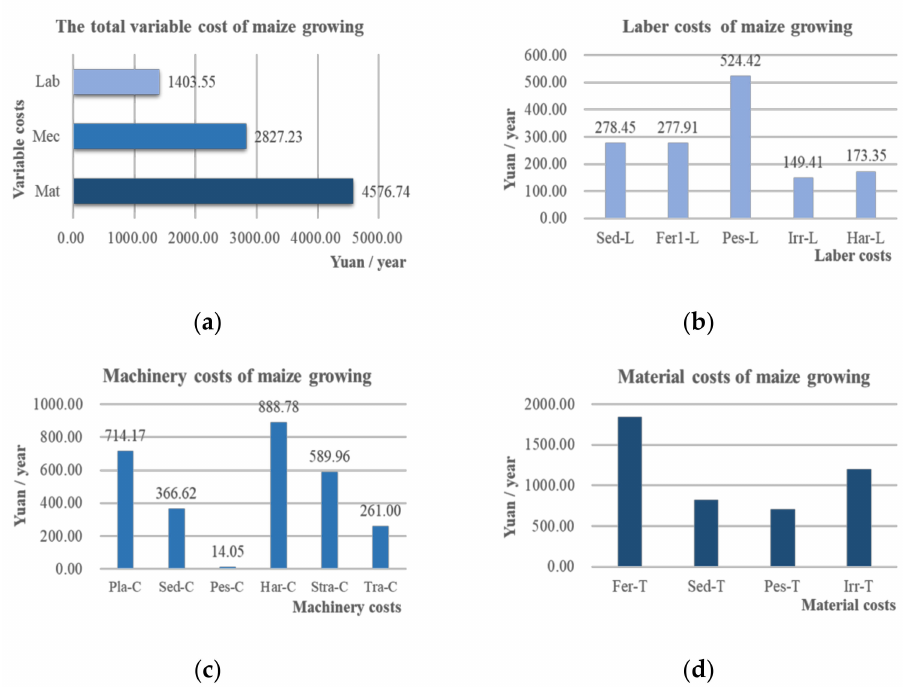
Figure 3. Composition of maize planting costs in Hengshui, Hebei Province, China. ( a ) Lab, Mec, and Mat represent labor costs, machinery costs, and material costs, respectively; ( b ) Sed-L, Fer1-L, Pes-L, Irr-L, Har-L are respectively the labor costs paid in sowing, fertilizing, pest control, irrigation, and harvesting, with household and hired labor included; ( c ) Pla-C, Sed-C, Pes-C, Har-C, Str a-C, Tra-C respectively indicate the use of machines to plow the land, sowing, spraying pesticides, harvesting, crushing straw, and transporting maize; ( d ) Sed-T, Fer-T, Pes-T, Irr-T respectively refer to the cost from purchasing seeds, fertilizers, pesticides, and